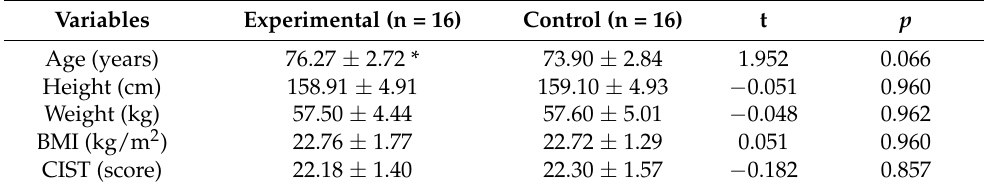
Table 3. General characteristics of the participants.